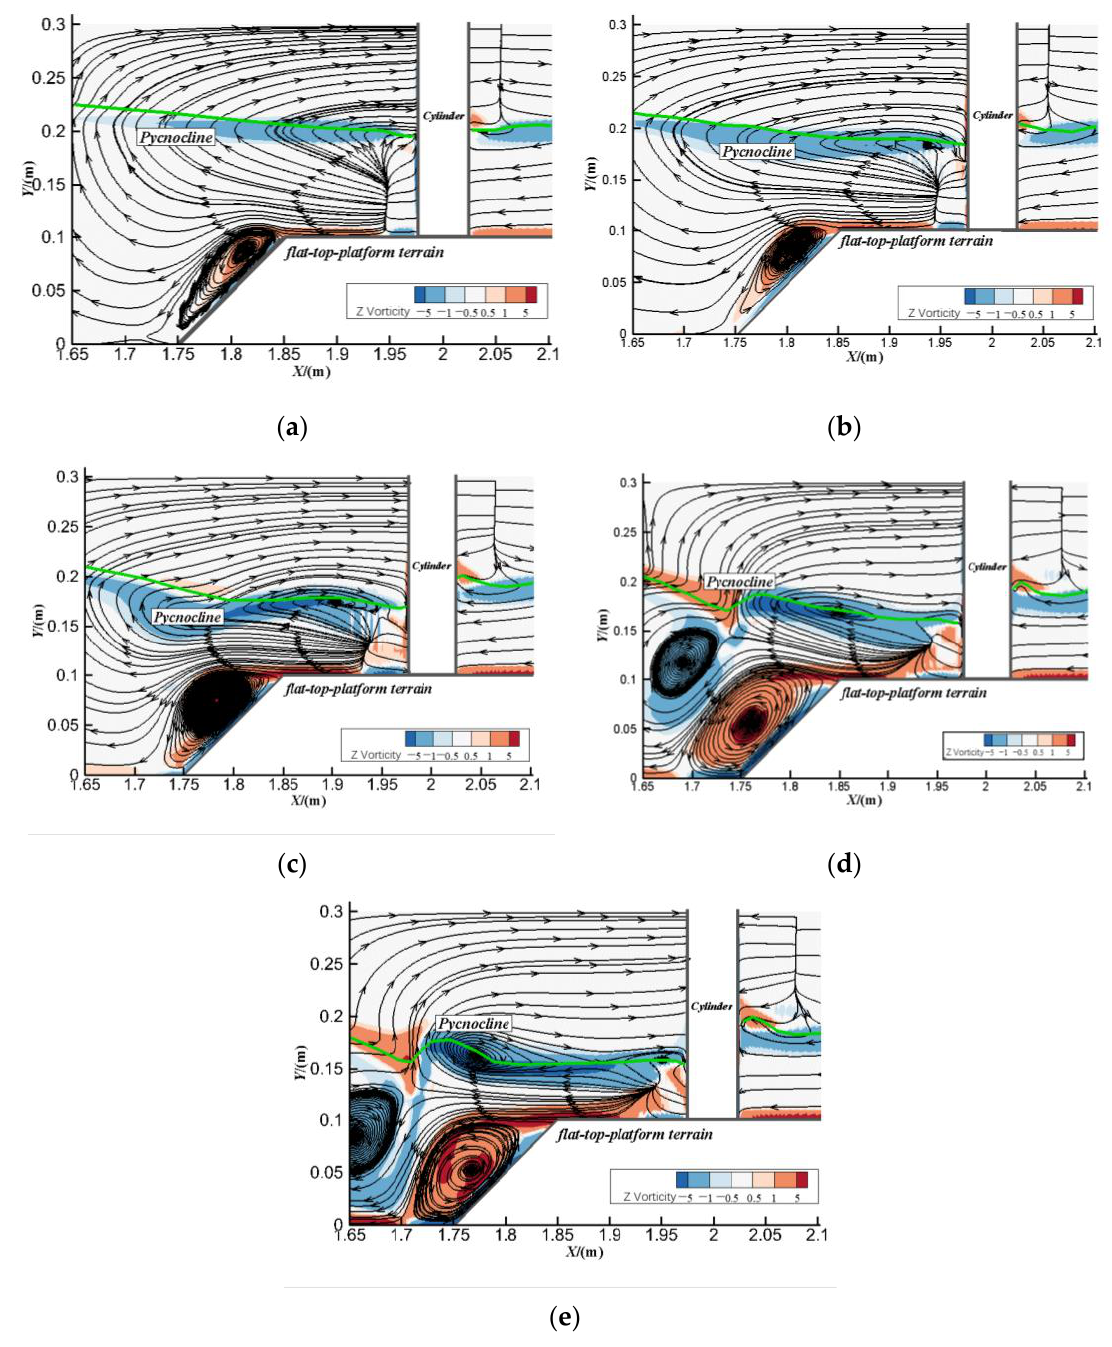
Figure 15. Plots of the flow field in Z direction, when C Fn = C Fn-max : ( a ) η 0 /H = 0.0275, ( b ) η 0 /H = 0.0384, ( c ) η 0 /H = 0.0494, ( d ) η 0 /H = 0.0575, ( e ) η 0 /H = 0.0674.